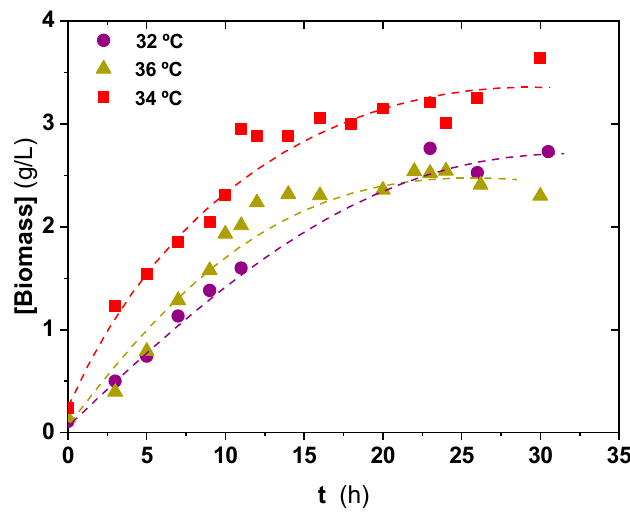
Figure 3. Biomass evolution with time showing Rhizopus arrhizus inoculum growth in medium B at several temperatures.